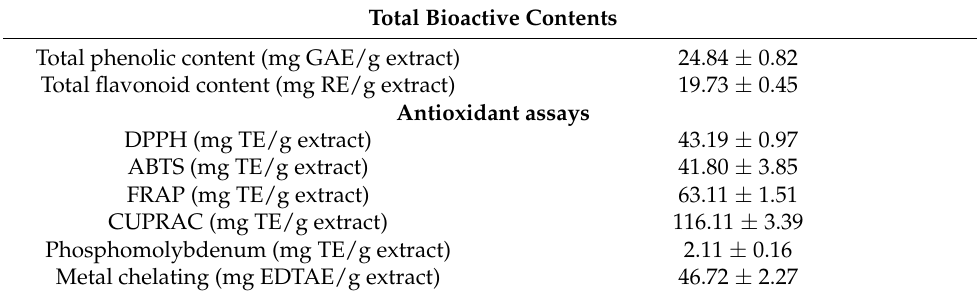
Table 1. Total bioactive contents and antioxidant activities of H. crispum .